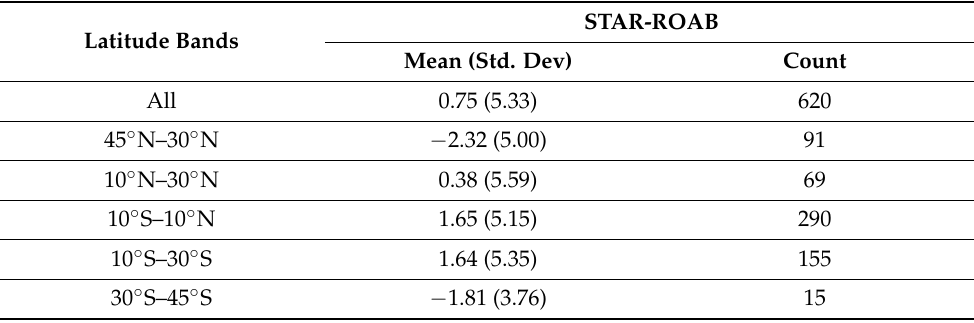
Table 2. The mean (Standard Deviation) of the RO-ROAB fractional difference and the number of collocated profiles at different latitude bands and SNR